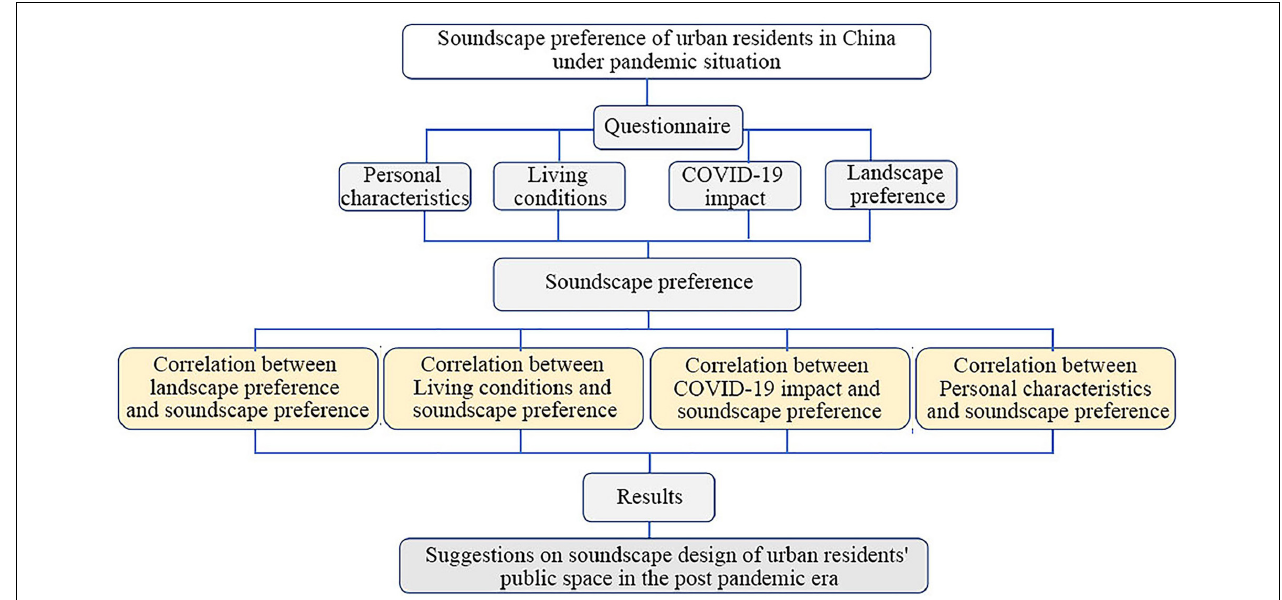
FIGURE 1 | Research